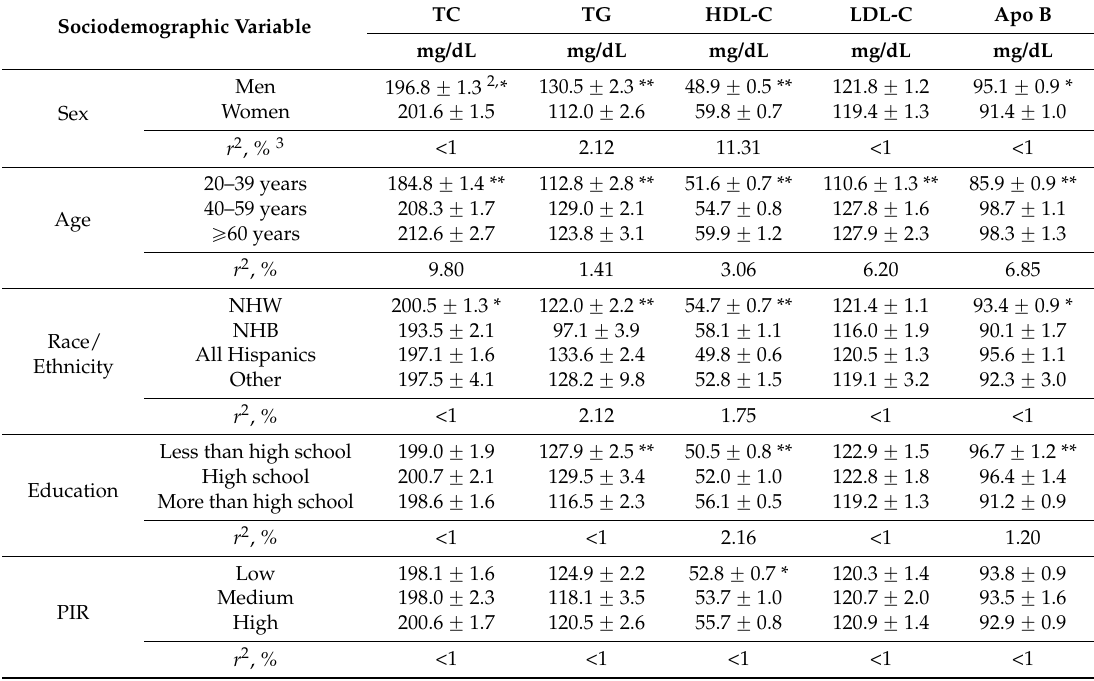
Table 1. Unadjusted serum lipid status biomarker levels by sociodemographic variable categories for US adults, NHANES 2007–2012 1